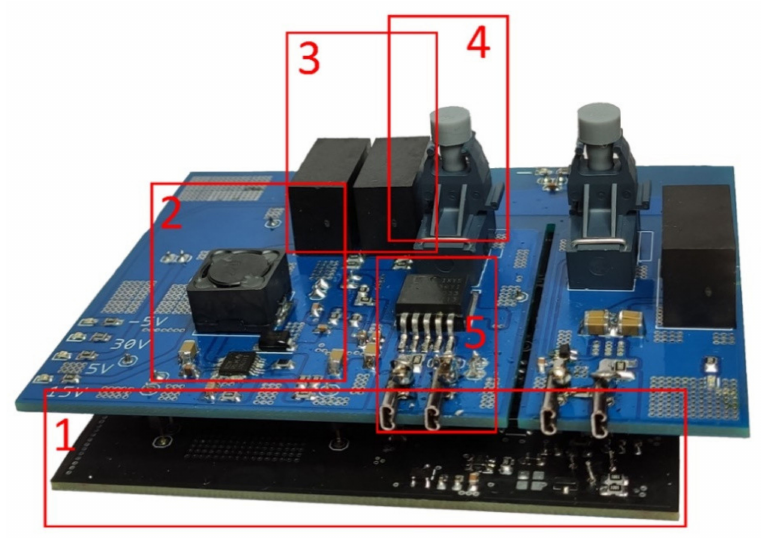
Figure 7. Photo of the designed AGD. 1—filtering and logical signal board (AGD input), 2—DC/DC boost converter 15/30 V, 3—isolated power supply, 4—optical receivers HFBR 2531-Z, 5—output of the